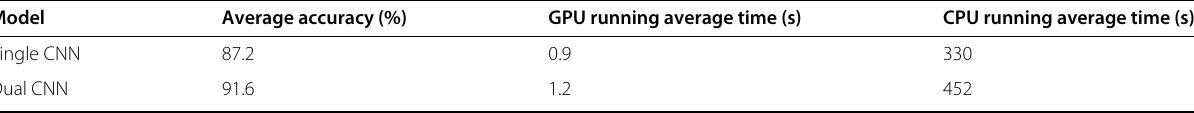
Table 2 Average accuracy rate and computation complexity of the two models